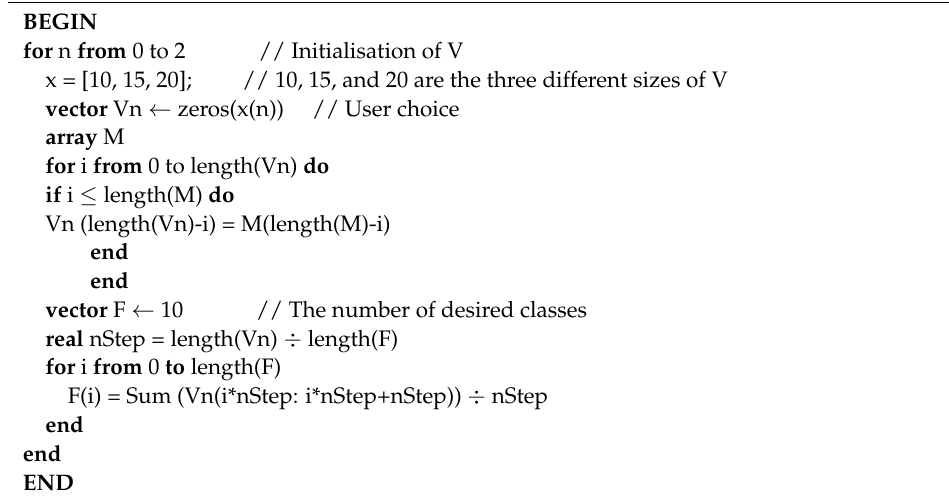
Algorithm 2: representation of the GDA output on a F